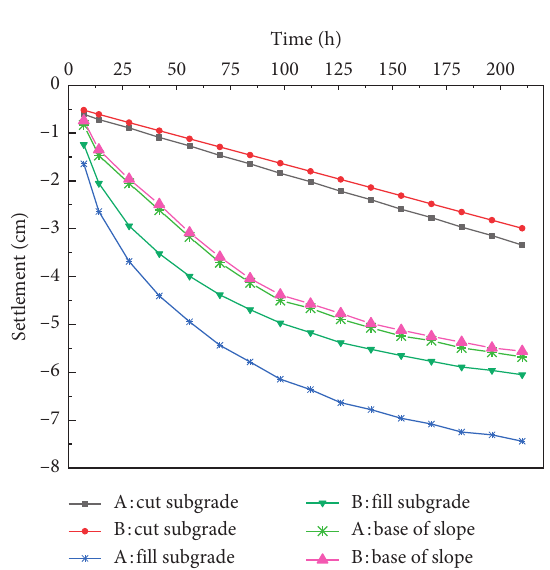
Figure 15: Development law of settlement of the horizontal cut to fill